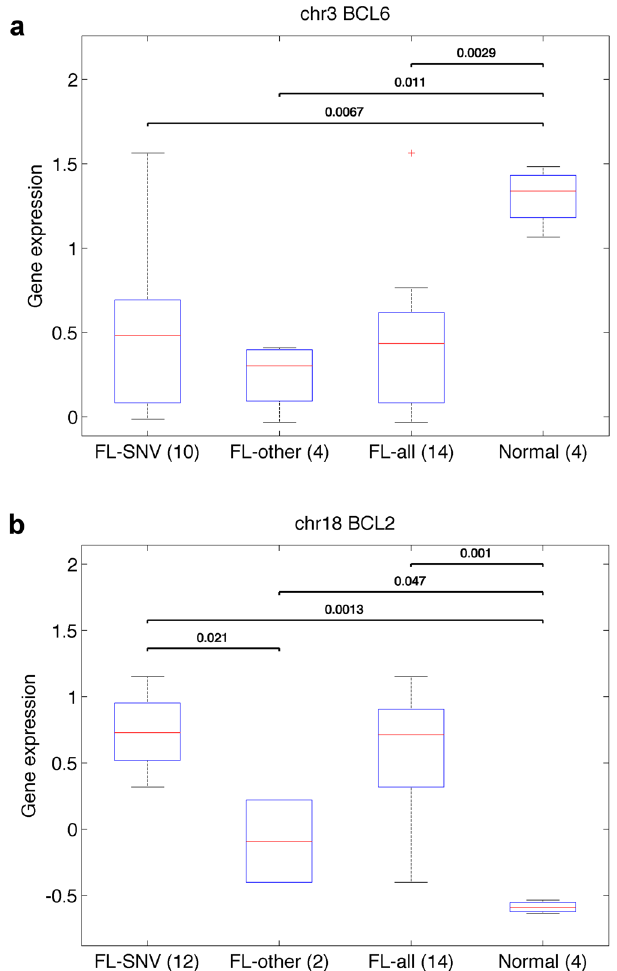
Figure 3. Box plot of gene expression levels of FL and GCB control samples. Here, FL-SNV represents FL patients with regulatory mutation blocks, FL-other represents FL patients without the regulatory mutation blocks, FL-all mean all 14 FL patients of test cohort, Normal means GCB control samples. The number of FL patients/control samples in the category is given in parentheses. P-value of the significance of KS test for difference between gene expressions in two categories is given above the bar connecting corresponding